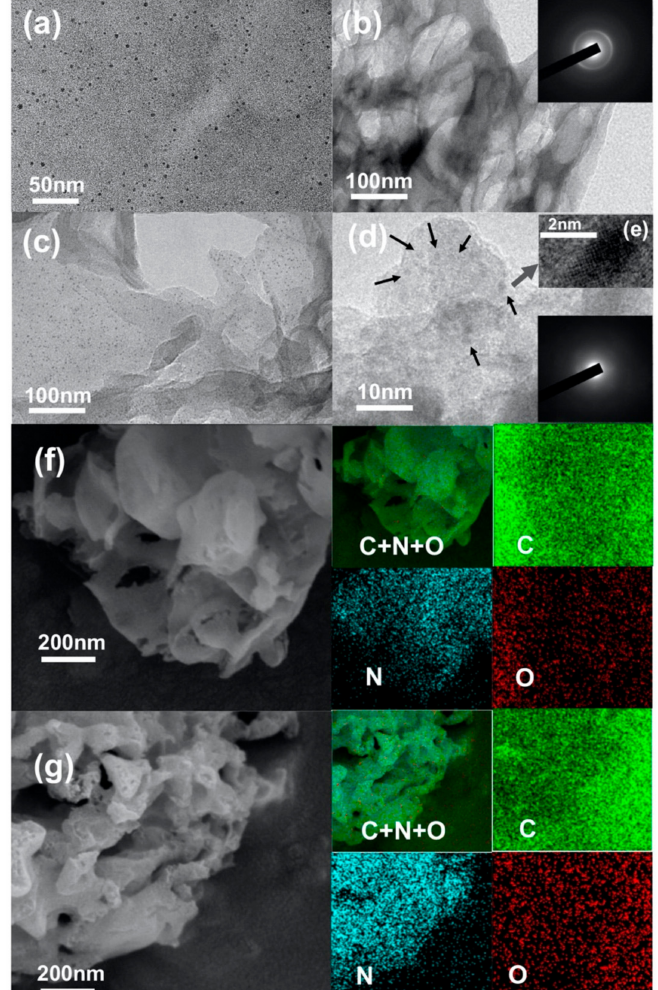
Figure 1. Transmission electron microscope (TEM) images of carbon quantum dots (CQDs) ( a ); g-C 3 N 4 sheets (CN) ( b ); ( c ) low- and; ( d ) high-magnification TEM images of carbon nitride photocatalyst (CCN); ( e ) HRTEM image of a CQD embedded in CCN, and SEM images together with elemental mapping of CN ( f ); and CCN ( g